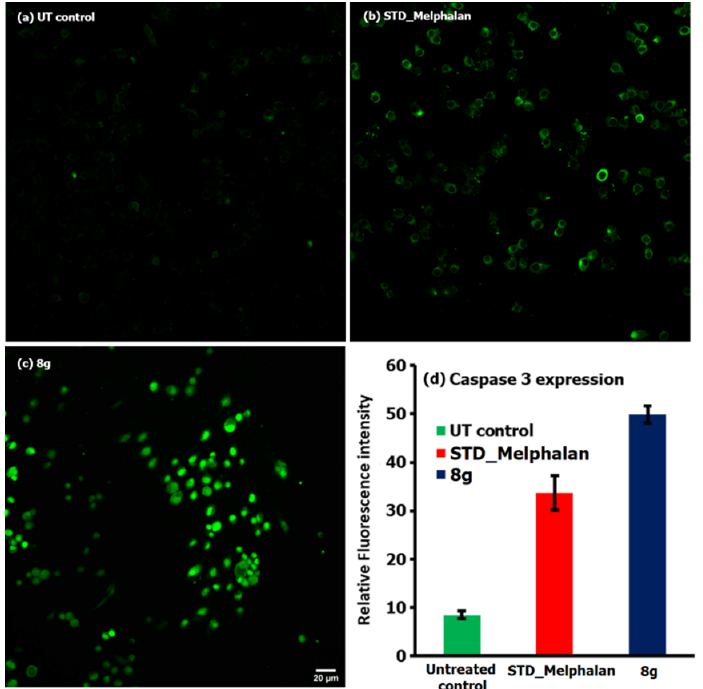
Figure 7. Comparison of caspase ‐ 3 activity results provided by the co ‐ incubation of HepG2 cells with the negative control having no cell treatment ( a ), treated with melphalan used as the positive control ( b ), and treated with the compound 8g ( c ) over a 48 h period. The relative fluorescence intensities of all the treatments were compared in ( d ).